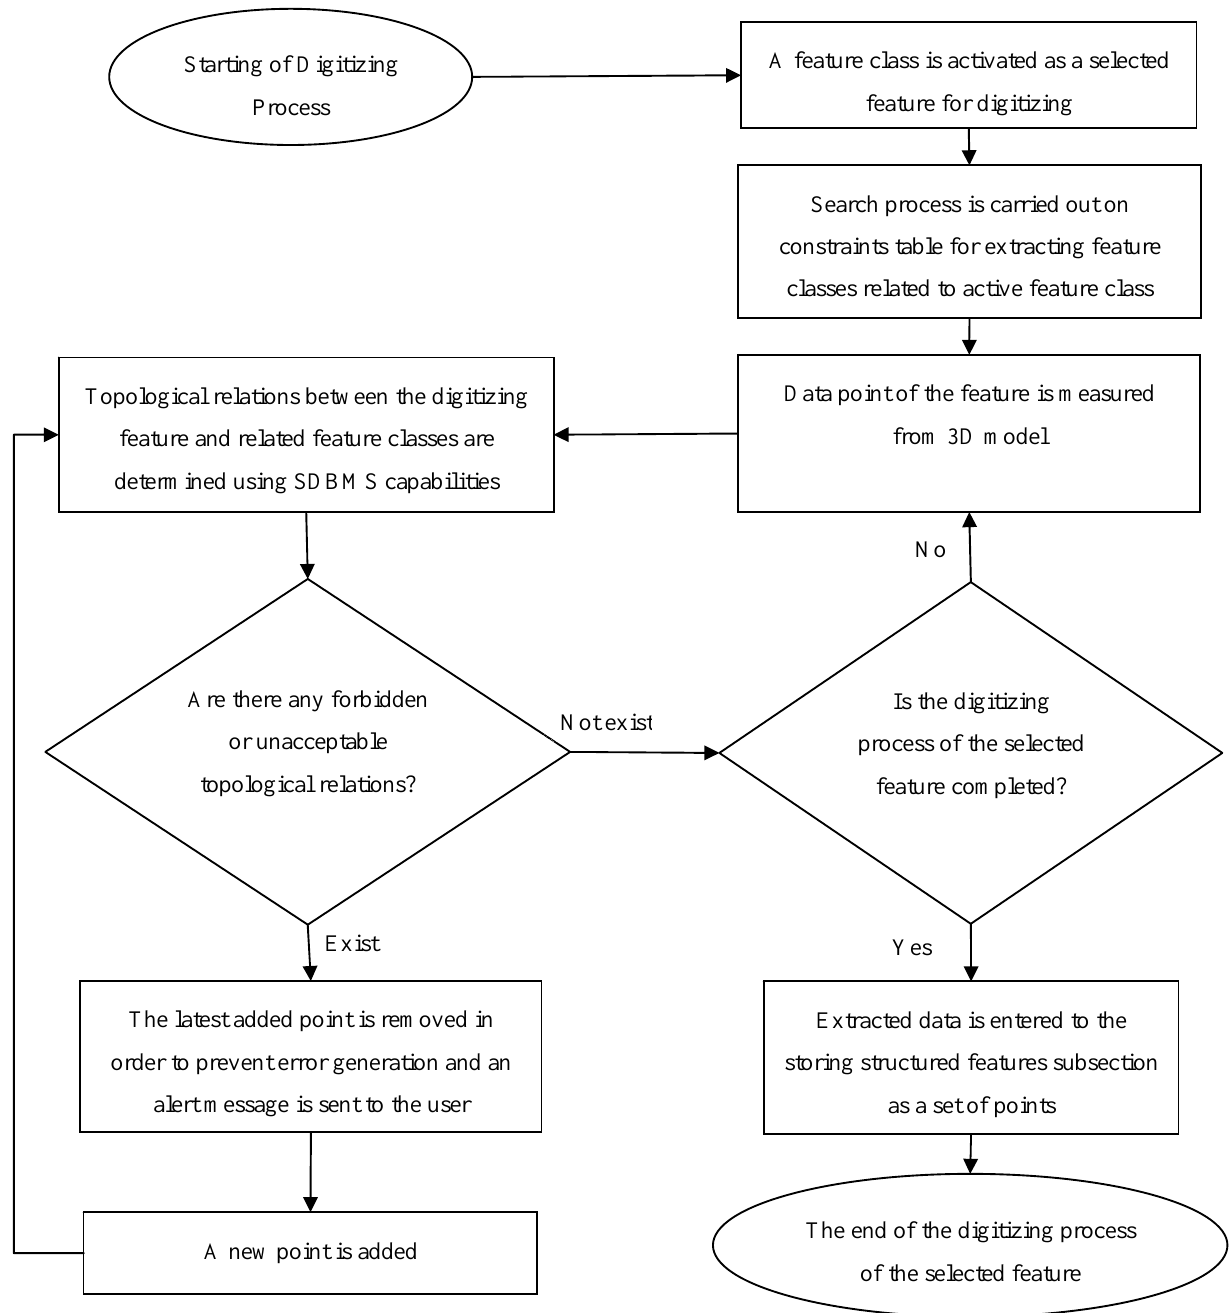
Figure 5 . The workflow of error removal